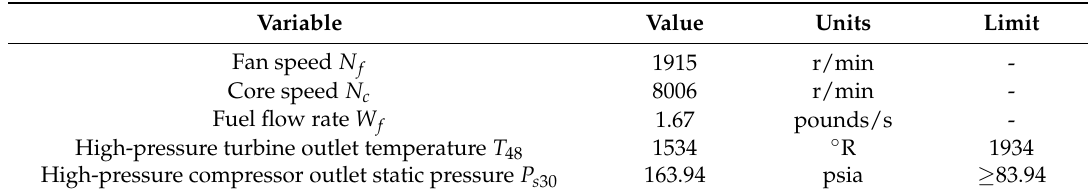
Table 1. Engine equilibrium values at 25,000 ft, Mach 0.62 and W f = 1.67